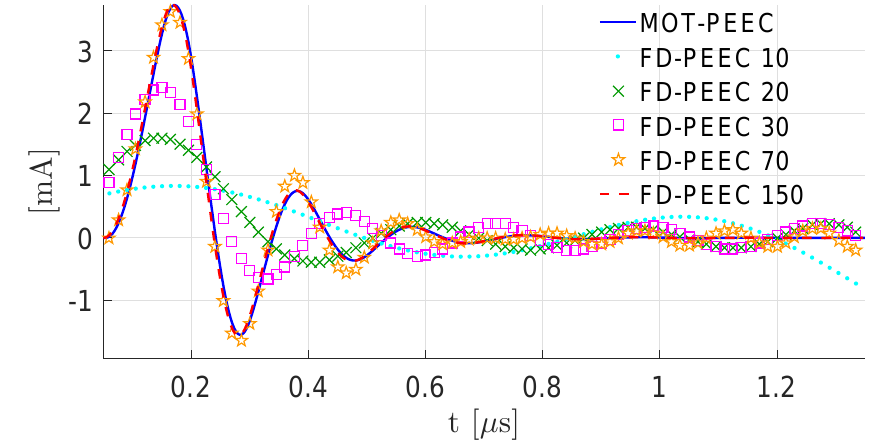
Figure 7. Current flowing in the VS connected to the NBI.